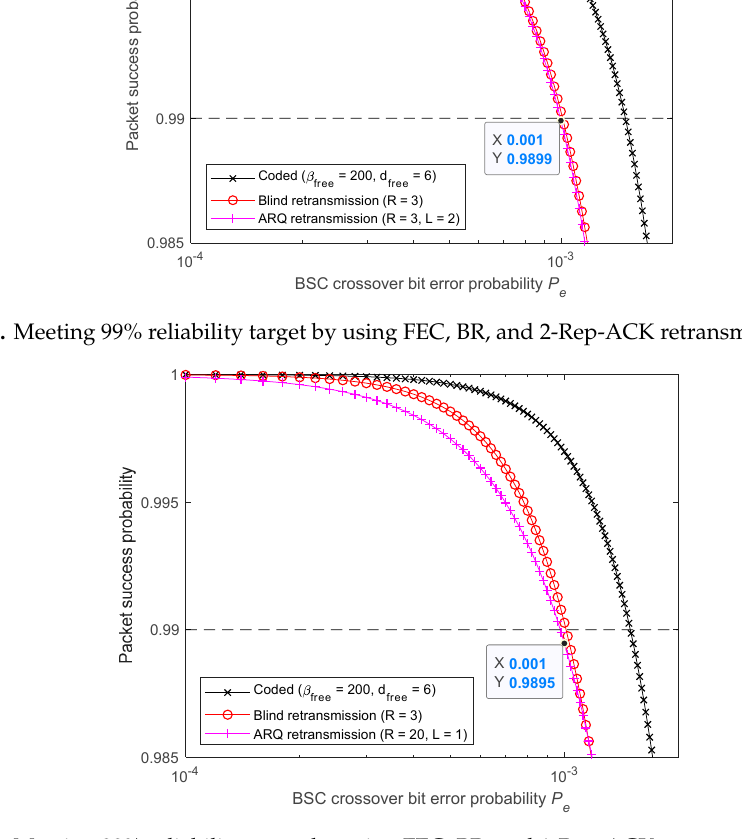
Figure 23. Meeting 99% reliability target by using FEC, BR, and 1-Rep-ACK retransmissions ( L = 1).